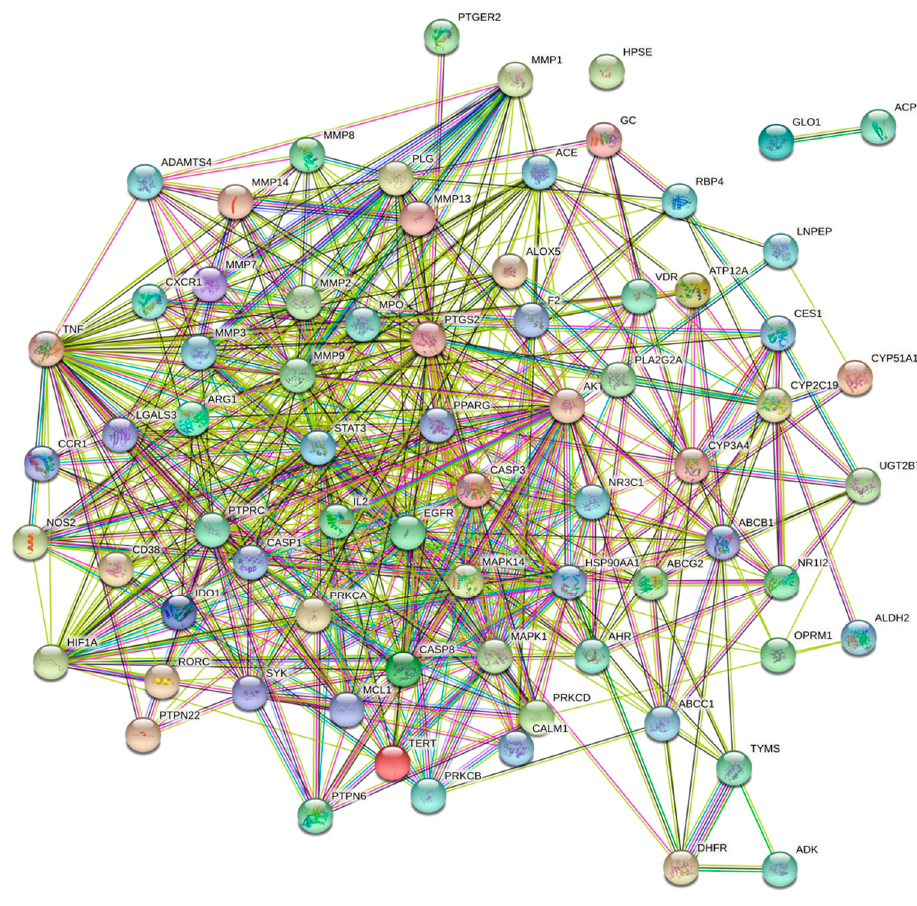
Figure 2. PPI Network of 72 intersected key targets(O.sanctum and Tuberculosis).